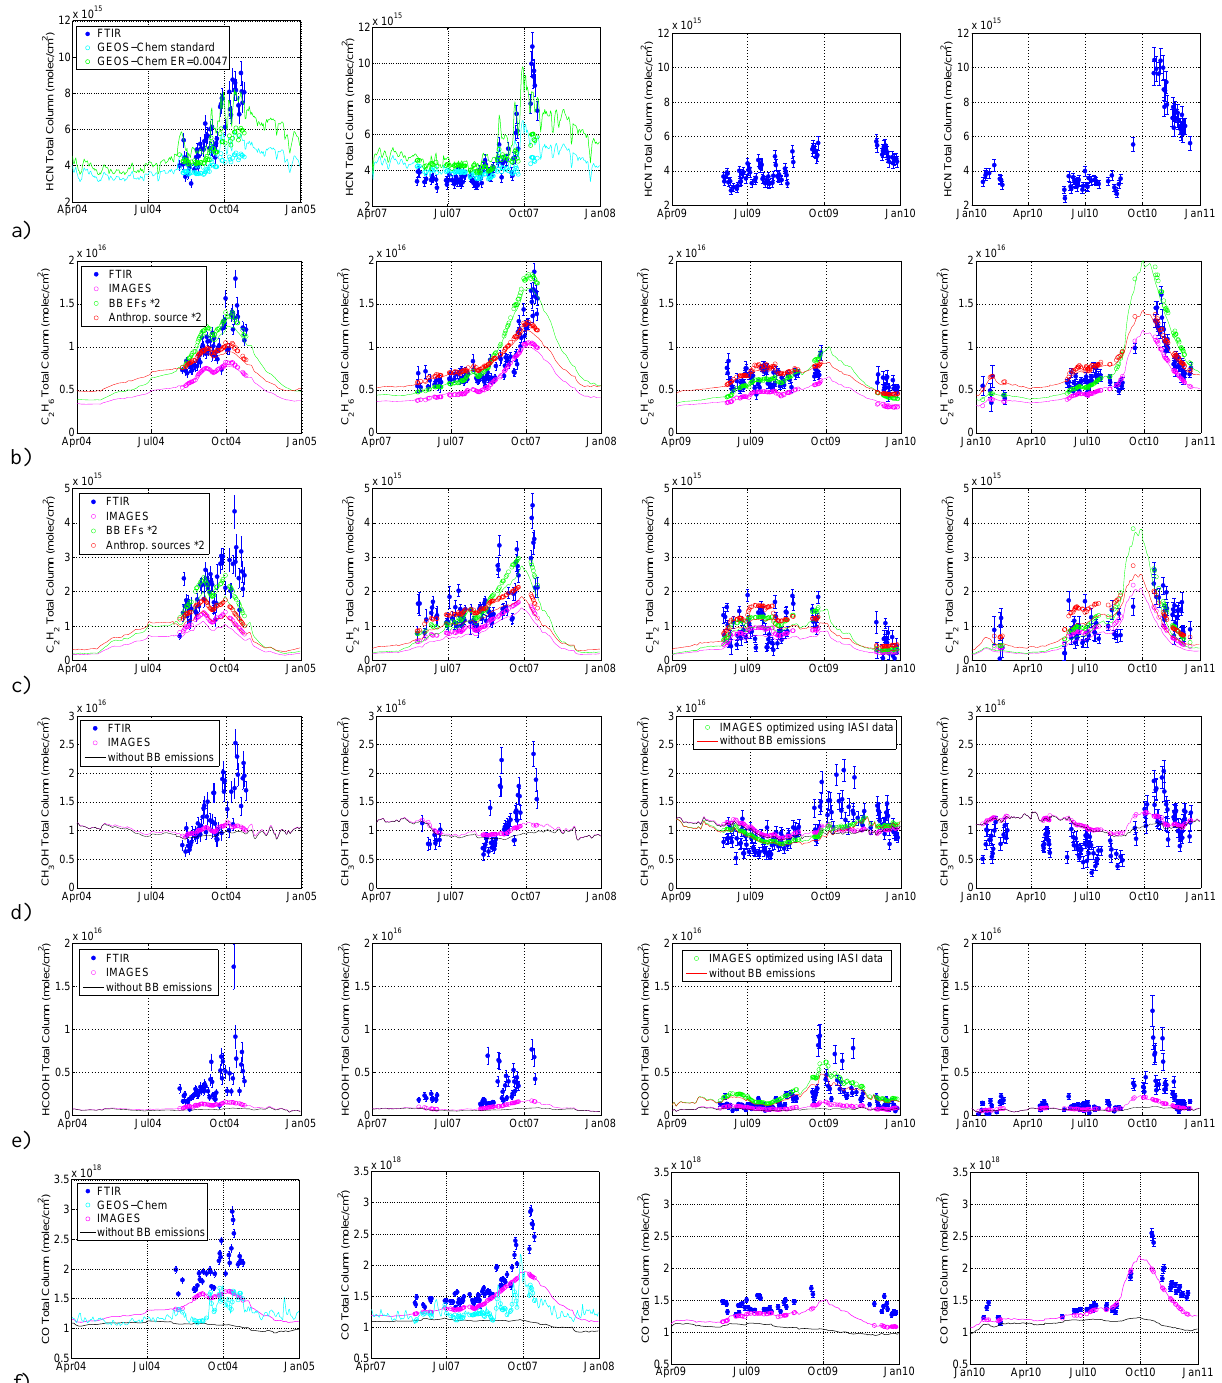
Fig. 4. Time-series of daily mean total columns at Reunion Island from: FTIR and GEOS-Chem HCN (a) , FTIR and IMAGES C 2 H 6 (b) , C 2 H 2 (c) , CH 3 OH (d) , and HCOOH (e) . We also show the time-series of CO from Duflot et al. (2010), extended to 2009 and 2010 (f) . From left to right, the columns cover the years 2004, 2007, 2009, and 2010. The FTIR data are represented by the blue filled circles, different model simulations with the coloured lines (cyan and magenta for the standard runs of GEOS-Chem and IMAGEs, respectively; green and red for the sensitivity tests: see Sect. 5), and the model data smoothed with the FTIR averaging kernels with the open circles. For CH 3 OH and HCOOH, the model simulations obtained when the biomass burning contribution is removed are shown in black for the standard run, and in red for the inversion using IASI data. (BB: biomass burning; ER: emission ratio; EF: emission factor; Anthrop.: